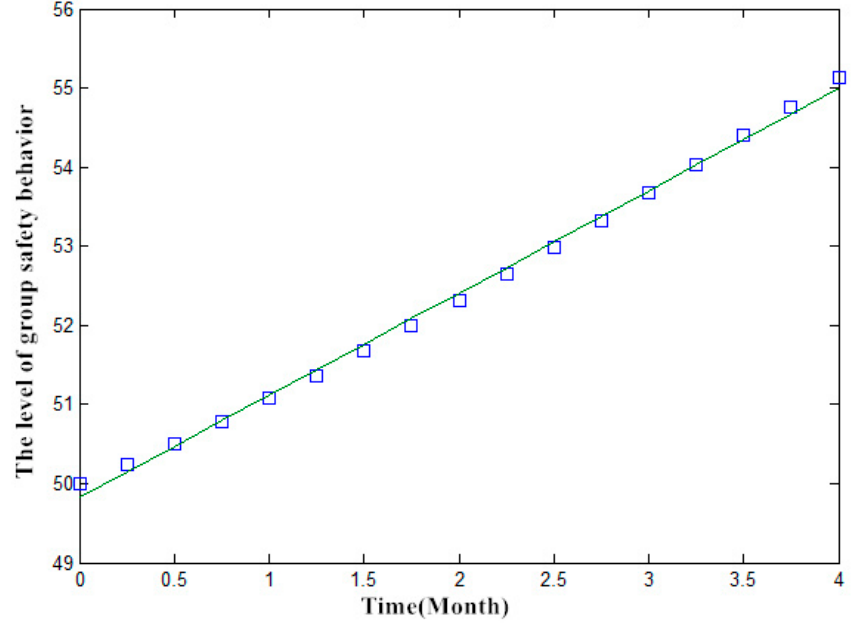
Figure 2. The intervention decision simulation diagram of EAP system. Line 1 shows the influence of psychological counseling and counseling on the level of group safety behavior, Line 2 shows the impact of safety investment on the level of group safety behavior, Line 3 shows the impact of upgrading work equipment on the level of group safety behavior, Line 4 shows the influence of recreational and sports activities on the level of group safety behavior, Line 5 shows the initial data. According to the average segmentation of the time series, there are 18 time periods, which are represented by T n (n = 1,2,3,4 . . . . . . 18), and each time period contains 4 months. Taking the linear regression analysis of the fund security investment decision K 2 in the T 1 time period as an example, the linear regression dot matrix diagram of the fund security investment in the time period T 1 is obtained, as shown in Figure 3, and the linear regression equation slope K 2T1 in the T 1 time period is obtained.